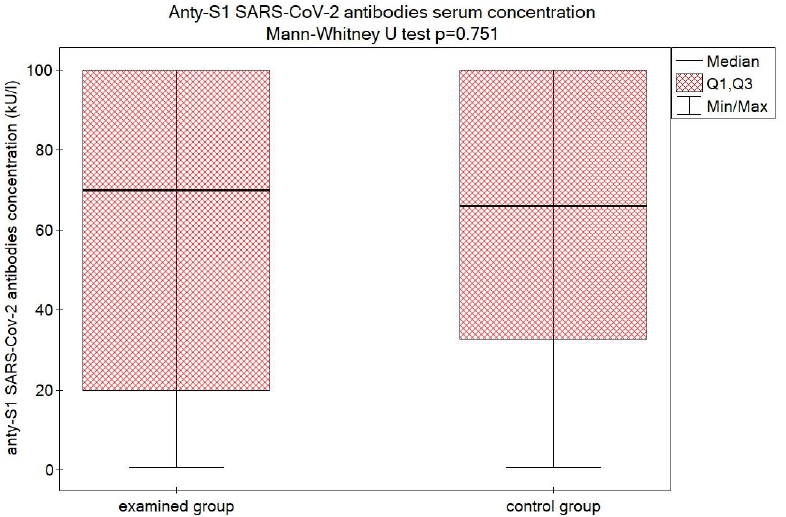
Figure 1. The comparison of the concentration of anti-S1 SARS-CoV-2 Spike protein IgG antibodies in the examined and control group.